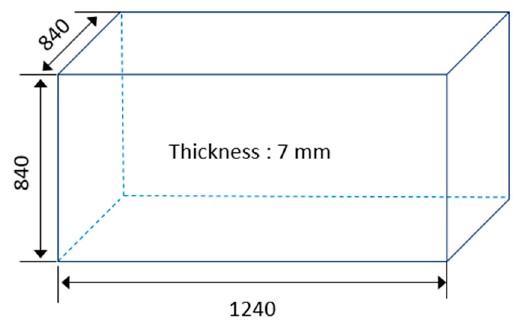
Figure 5. The properties and shapes of experimental models. Table 8. The comparison results.